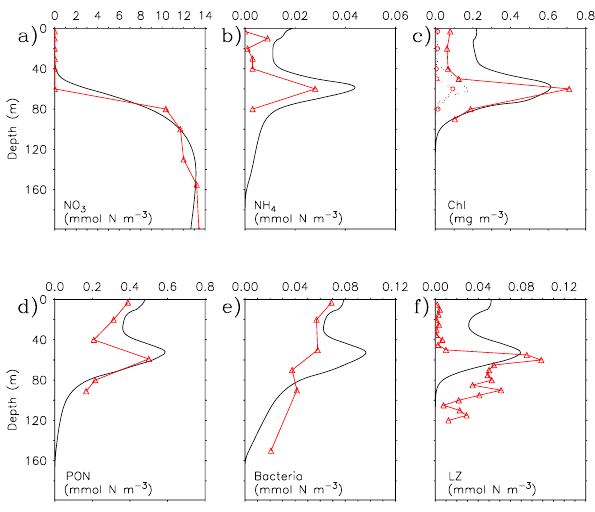
Fig. 5. Model–data comparisons (scalars) for the “standard” run. Model outputs are in black and observations in red: (a) NO 3 , (b) NH 4 , (c) Chl for SP and LP (in the model, full and dashed lines, respectively; in observations, triangles and circles, respec- tively), (d) PON (i.e., sum of LP, SP, SZ, BACT and dPON in the model), (e) biomass of bacteria and (f) LZ.